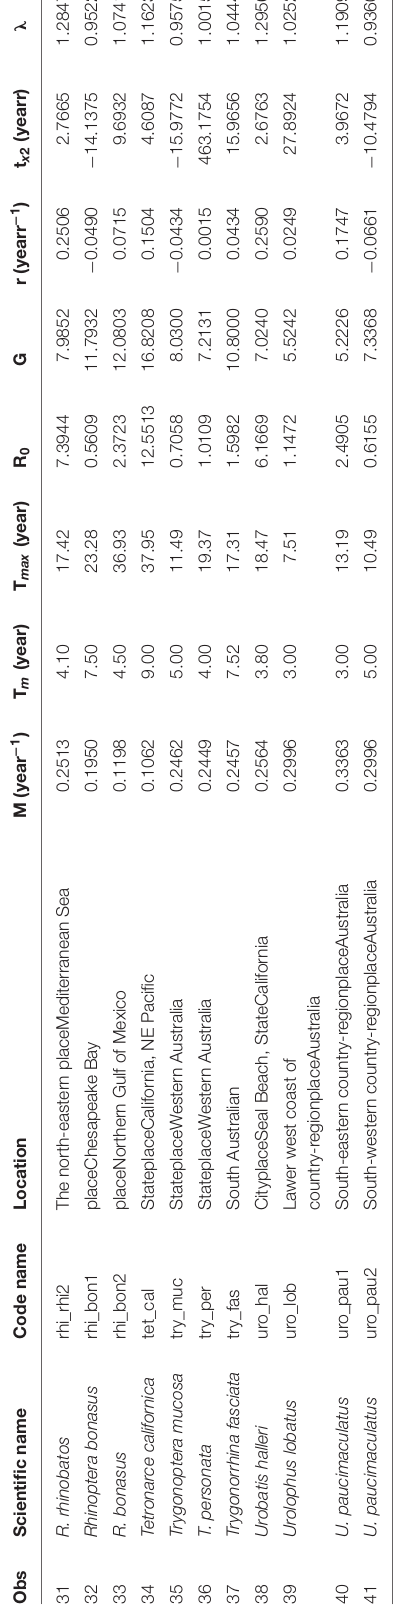
The L max of 35 species (41 stocks) ranged from the minimum of 53.9 and 54.0-cm TL for the sharpspine skate and little skate (Waring, 1984; Joung et al., 2011) to the maximum of 235.0- cm TL for the blue skate Dipturus batis (Du buit, 1977) with a median of 103.4-cm TL. For age and growth parameters, the minimum L ∞ was 52.7-cm TL for little skate (Waring, 1984), and the maximum L ∞ was 293.5-cm TL for the big skate (McFarlane and King, 2006) with a median of 125.8-cm TL. The k value ranged from the minimum of 0.040 year − 1 for the big skate (McFarlane and King, 2006) to the maximum of 0.454 year − 1 for the starry skate (Serena et al., 2005), with a median of 0.112 year − 1 ( Supplementary Table 1 ). Among the stocks collected for this study, 23 stocks are oviparity, four stocks are aplacental viviparity, and 14 stocks are viviparity. The fecundity of oviparous stocks ranged from 8 for the roughtail skate and the sandpaper skate Bathyraja interrupta (Ebert, 2005) to 360 for the big skate (Ebert and Davis, 2007) with a median of 40. For viviparous stocks, the fecundity ranged from 1 for the cownose ray Rhinoptera bonasus (Smith and Merriner, 1986), the western shovelnose stingaree, and the masked stingaree (White et al., 2002) to 5 for pelagic stingray (Hemida et al., 2003) with a median of 3. The fecundity of aplacental viviparous stocks ranged from 5 for the southern fiddle ray Trygonorrhina fasciata (Marshall et al., 2007) to 17 for the Pacific electric ray (Neer and Cailliet, 2001). Among those 18 stocks where their gestation periods have been documented, 15 stocks have 1-year gestation period, the Pacific electric ray has 2.5-year gestation period (Neer and Cailliet, 2001), and the diamond stingray and round stingray have 0.5-year gestation period (Babel, 1967; Hemida et al., 2003) ( Supplementary Table 1 ). For those species without gestation period information, gestation period or R c was estimated using the value from similar species or assumed to be 1 year. The L b / L ∞ ratios of the 35 species (41 stocks) ranged from 0.083 to 0.483, with a median value of 0.165. The maximum value of L b / L ∞ was 0.483 for the white-spotted stingaree (White and Potter, 2005), and the minimum value was 0.083 for big skate (McFarlane and King, 2006) with a median of 0.165. In total, 26 stocks (63.41%) ranged from 0.102 to 0.200, five stocks (12.20%) ranged from 0.083 to 0.093, and 10 stocks ranged from 0.211 to 0.483 (24.39%) ( Supplementary Table 2 ). The L m / L ∞ ratios ranged from 0.307 to 0.855, with a median value of 0.641. The maximum value of L m / L ∞ was 0.855 for the white-spotted stingaree in southwestern Australia (White and Potter, 2005), and the minimum value was 0.307 for the big